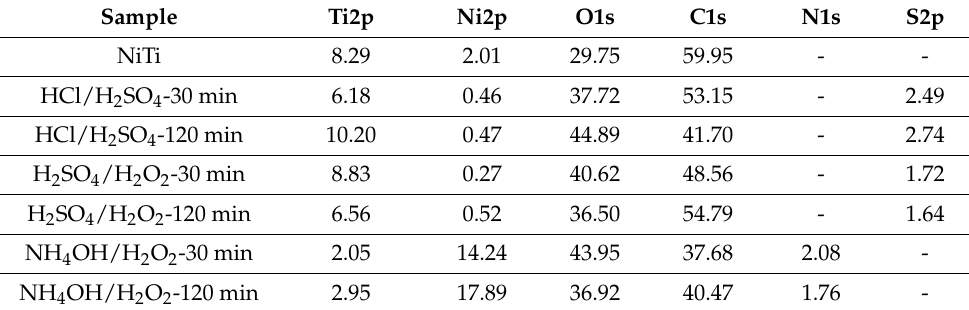
Table 2. Data of XPS quantitative analysis.